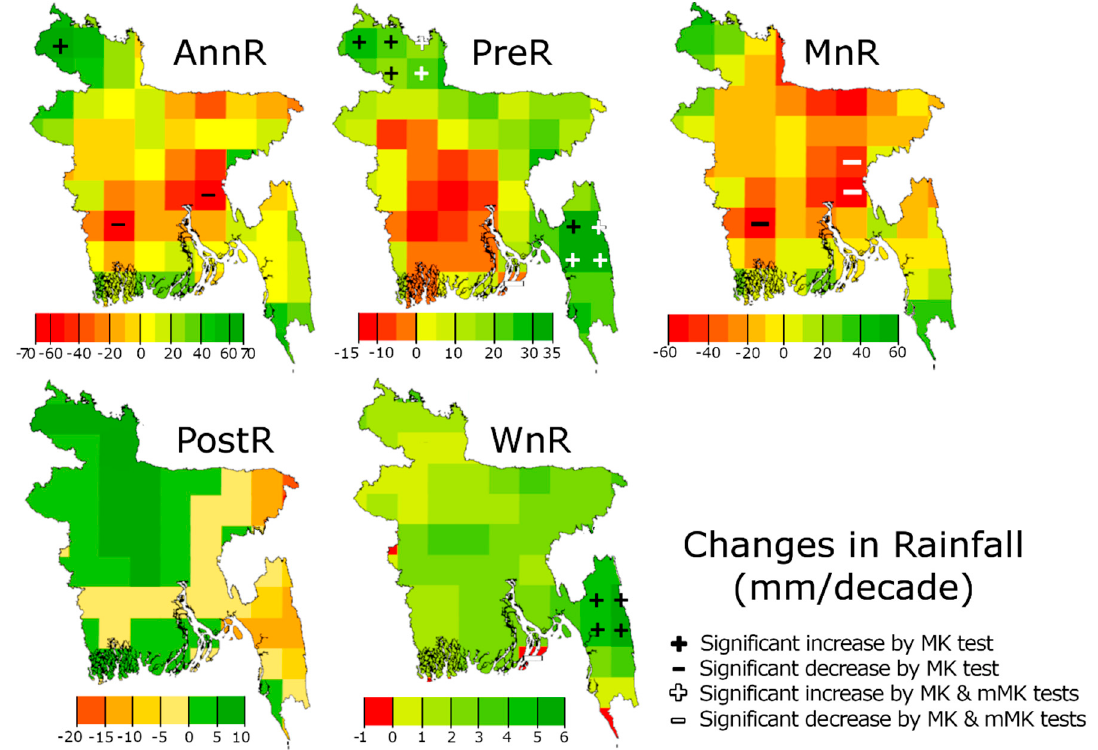
Figure 13. Spatial distribution of long-term trends (1901–2017) in annual and seasonal rainfall in Bangladesh obtained using Global Precipitation Climatology Centre (GPCC) data.